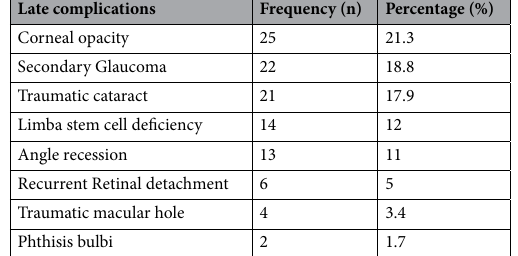
Table 5. Late complications in the eyes of Saudi children following fireworks-related ocular injuries.